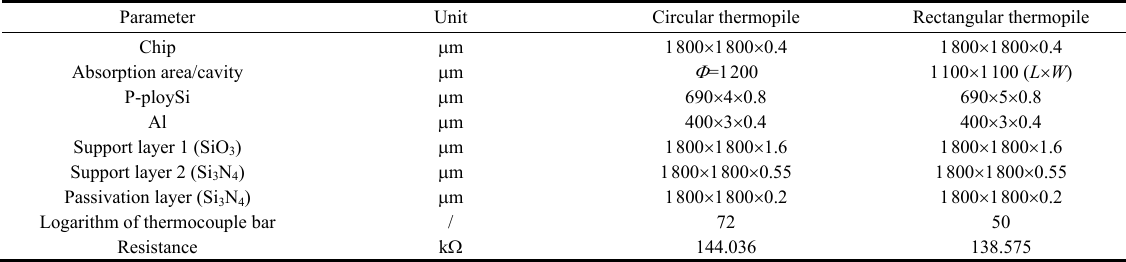
Table 1 Structural parameters of the thermopile designed in this